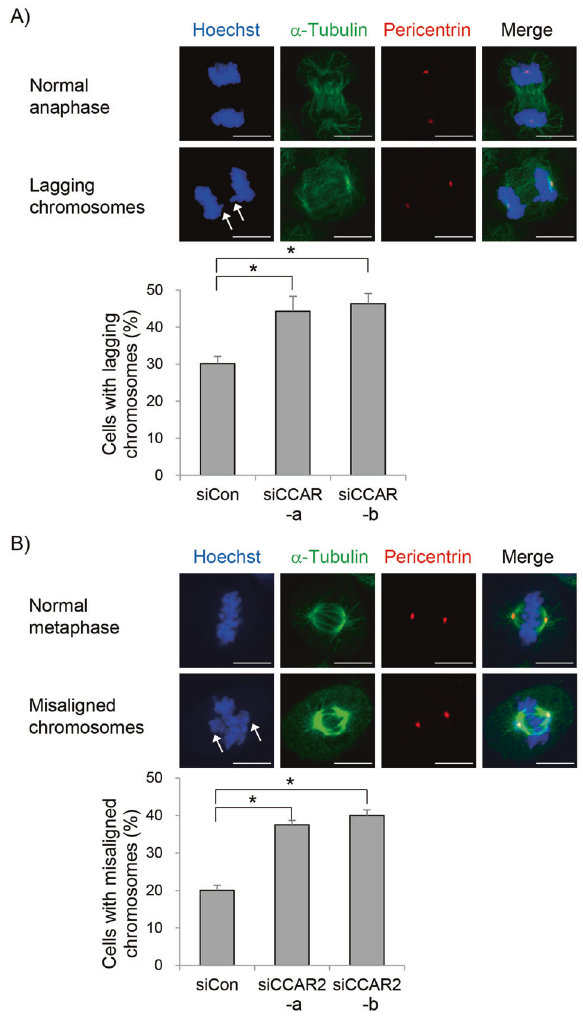
Fig. 6 CCAR2 de fi ciency induces misaligned and lagging chromo- somes. A Asynchronous cells were stained with Hoechst, anti- α - tubulin and anti-pericentrin antibodies. The number of cells containing lagging chromosomes at anaphase was counted from out of more than 20 anaphase cells per experiment. The experiment was repeated independently ( N = 6). The number of anaphase examined in all experiments was as follows; siCon, n = 140; siCCAR2- a, n = 142; siCCAR2-b, n = 138. B Cells were treated for 3 h with 50 μ M monastrol. Arrested cells with monopolar spindles were washed out to allow recovery for 1.5 h in the presence of 20 μ M MG132. The number of cells containing misaligned chromosomes at metaphase was counted from out of more than 30 metaphase per experiment. The experiment was repeated independently ( N = 3). The number of metaphase examined in all experiments was as follows; siCon, n = 130; siCCAR2-a, n = 121; siCCAR2-b, n = 128. Data are expressed as the mean ± SEM. * p < 0.05, signi fi cantly different between multiple groups (one-way ANOVA); scale bar, 10 μ